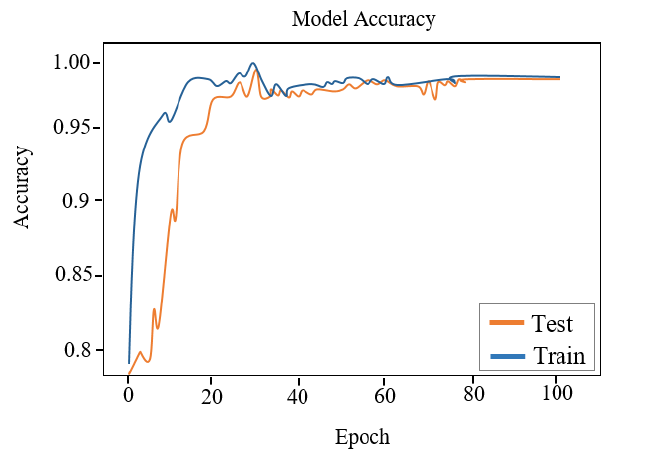
Figure 9. Predicted distributions of the 5 classes of medicinal plants images based on their sizes of ( a ) 64 × 64, ( b ) 128 × 128, and ( c ) 256 × 256 pixels .